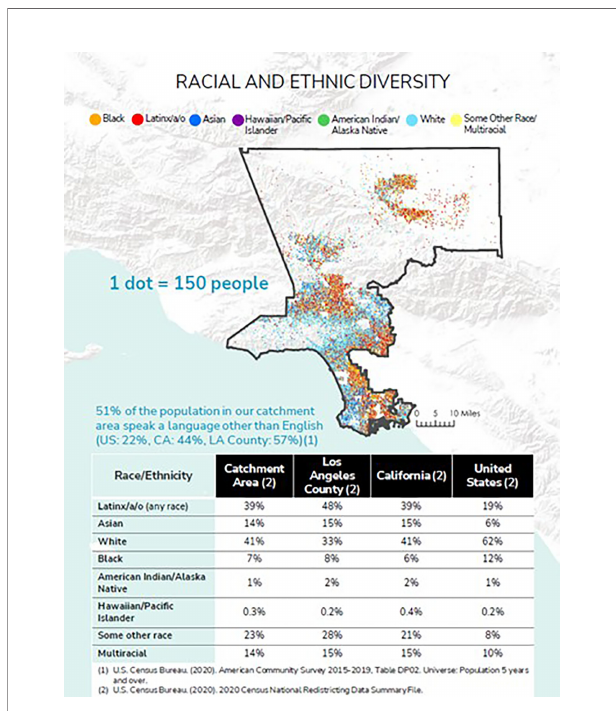
FIGURE 3 | Catchment area population by race and